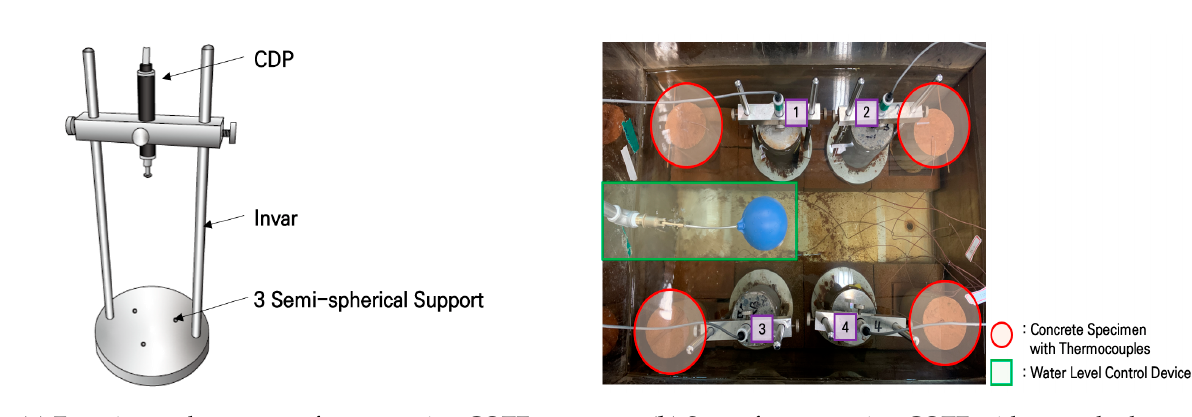
Figure 2. Experimental apparatus for measuring COTE and system setup [45].